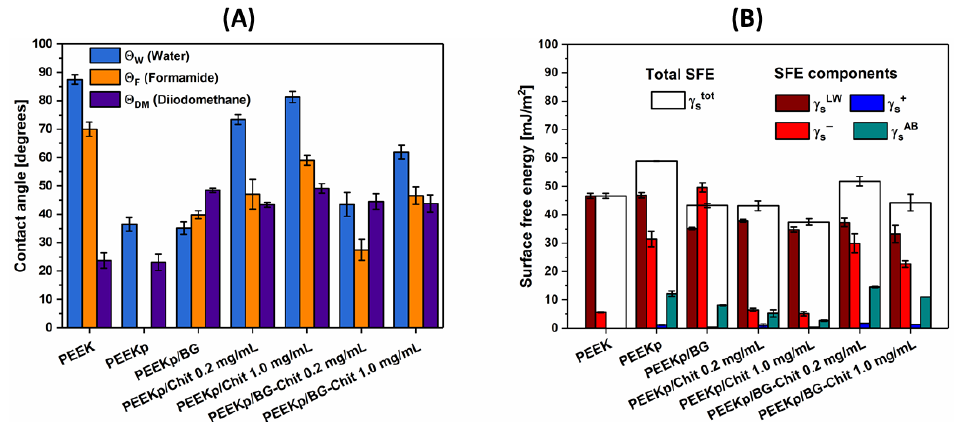
Figure 7. ( A ). Mean contact angle of water, formamide, and diiodomethane, and ( B ) surface free energy, as well as its components determined for the modified PEEK surfaces. The error bars in ( A ) denote standard deviations from 10–15 contact angle values of single test liquid of each surface (twice). The error bars in ( B ) denote the maximum and minimum values of surface free energy and its components calculated for 2 samples of each studied surface from the 10–15 contact angle values of each liquid (their averages). The commercial PEEK revealed a hydrophobic character (contact angle of water Θ (cid:3024) = 87.5°), which is consistent with the findings of other authors and our previous stud- ies [39,40]. The contact angle for more polar formamide was estimated to be Θ (cid:3007) = 70.0° and Θ (cid:3005) = 23.7° for the non-polar diiodomethane. The hydrophilic-hydrophobic character of the PEEK surface changed significantly after the plasma treatment ( Θ (cid:3024) = 36.4°). This was due to the surface activation and creation of multiple polar groups on the PEEK sur- face rich in oxygen and nitrogen. The observed effect was even larger for formamide ( Θ (cid:3007) = 0.0°—total wetting), but not noticeable in the case of diiodomethane ( Θ (cid:3005) = 23.1°). The contact angles of water did not change significantly after the deposition of BG ( Θ (cid:3024) = 35.2°), nevertheless, it was possible to measure the contact angle of formamide ( Θ (cid:3007) = 39.8°) (Figure 7A). Additionally, the contact angle of diiodomethane changed sig- nificantly and was equal to Θ (cid:3005) = 48.5°. Considering the SEM images, the activated PEEK surface was found to be covered evenly but partially with the BG. Those contact angles